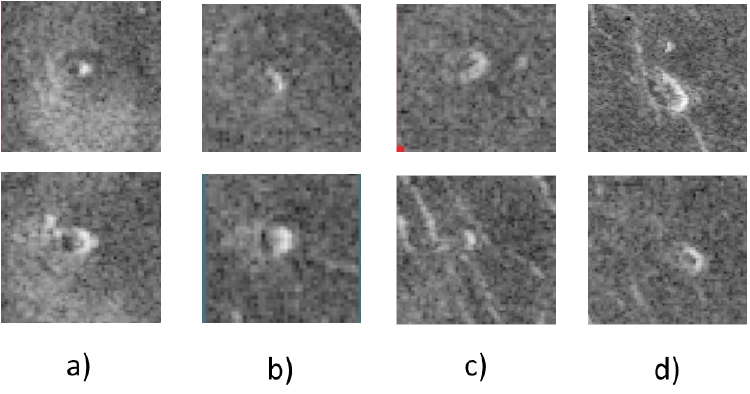
Figure 3. Defined volcano classes in the dataset: ( a ) Category 1, ( b ) Category 2, ( c ) Category 3, ( d ) Category 4